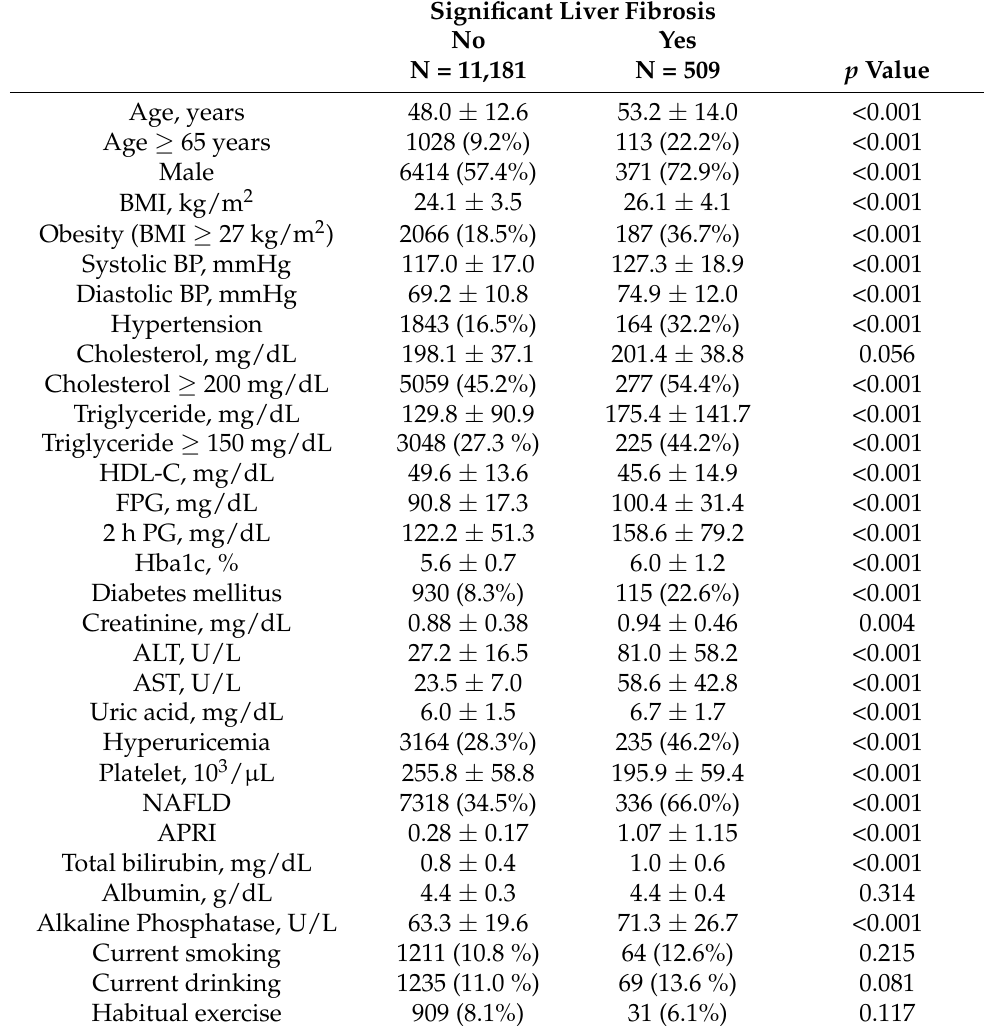
Table 1. Comparisons of clinical parameters in subjects with and without significant liver fibrosis.